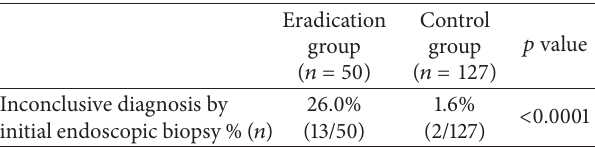
Table 3: Prevalence of inconclusive diagnosis of gastric cancer by initial endoscopic